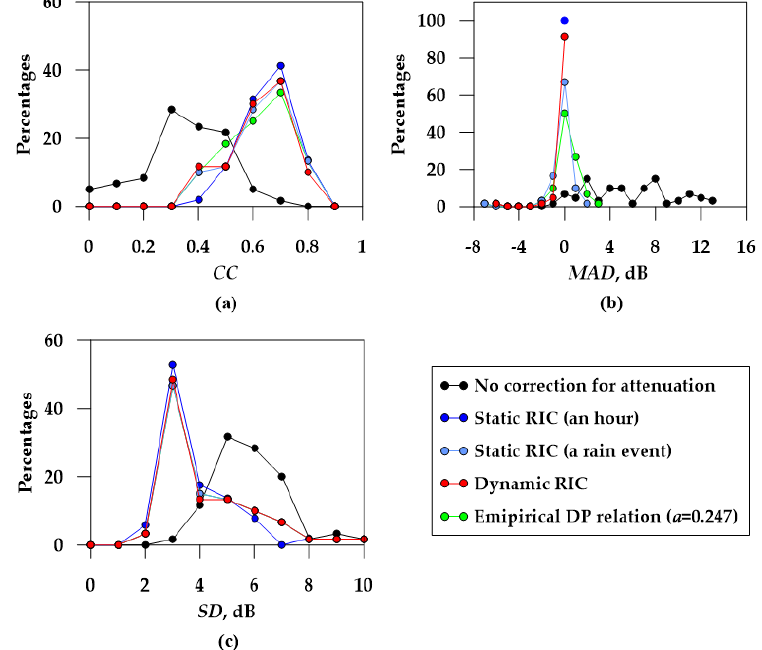
Figure 9. Probability distribution graphs of corrected results of five correction methods using 59 h segment data from 20 July 2016: ( a ) CC , ( b ) MAD , and ( c ) SD . Table 4. Improved percentage differences between results after attenuation correction and results before attenuation correction.